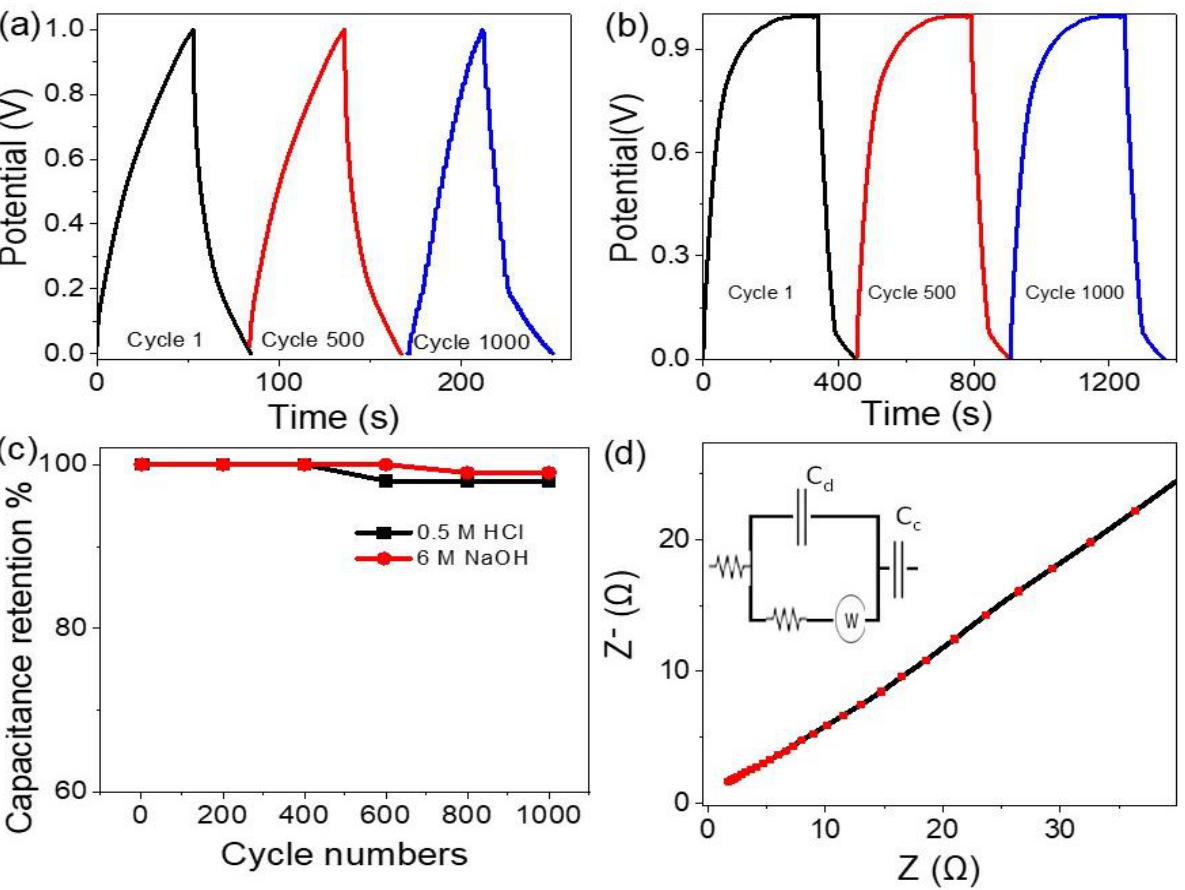
Figure 4. The cycle lifetime of the supercapacitor using the electrolytes ( a ) 0.5 M HCl and ( b ) M NaOH. ( c ) Capacitance retention using different electrolytes and ( d ) the impedance of the supercapacitor in basic medium 6 M NaOH.